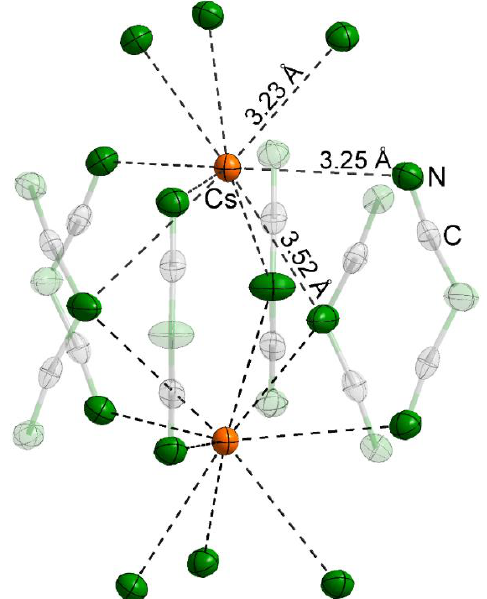
Figure 2 . Coordination sphere of Cs in LiCs 2 [dca] 3 . Atoms not involved have been greyed out. The thermal ellipsoids correspond to 90% probability using the refined ADPs.